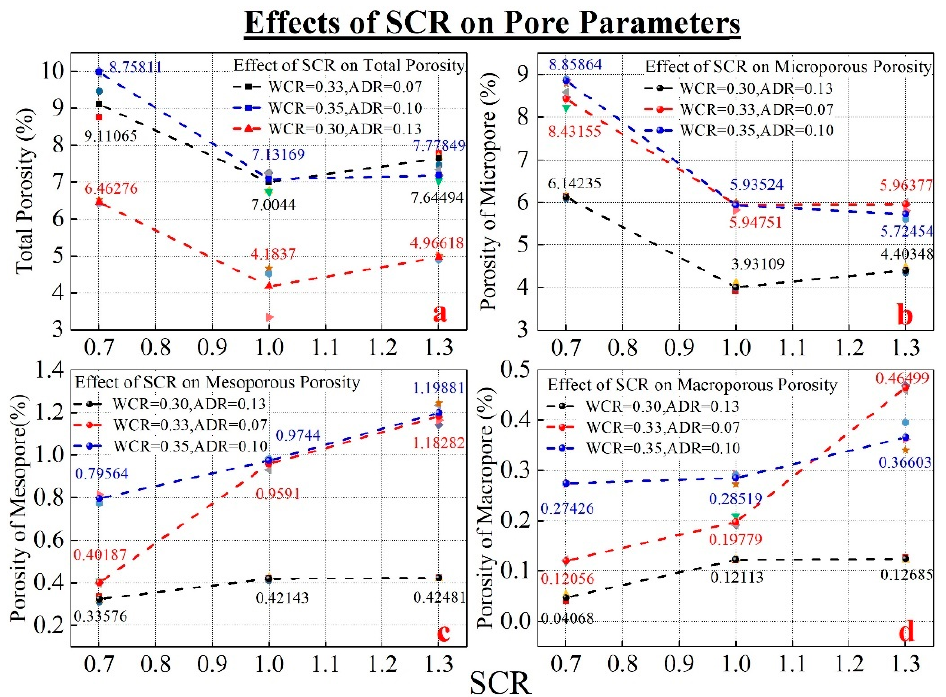
Figure 7. The influence of SCR on microporous, mesoporous, and microporous porosity. ( a ) shows the effect of SCR on the porosity. ( b ) shows the effect of SCR on the microporous porosity. ( c ) shows the effect of SCR on the mesoporous porosity. ( d ) shows the effect of SCR on the macroporous porosity.